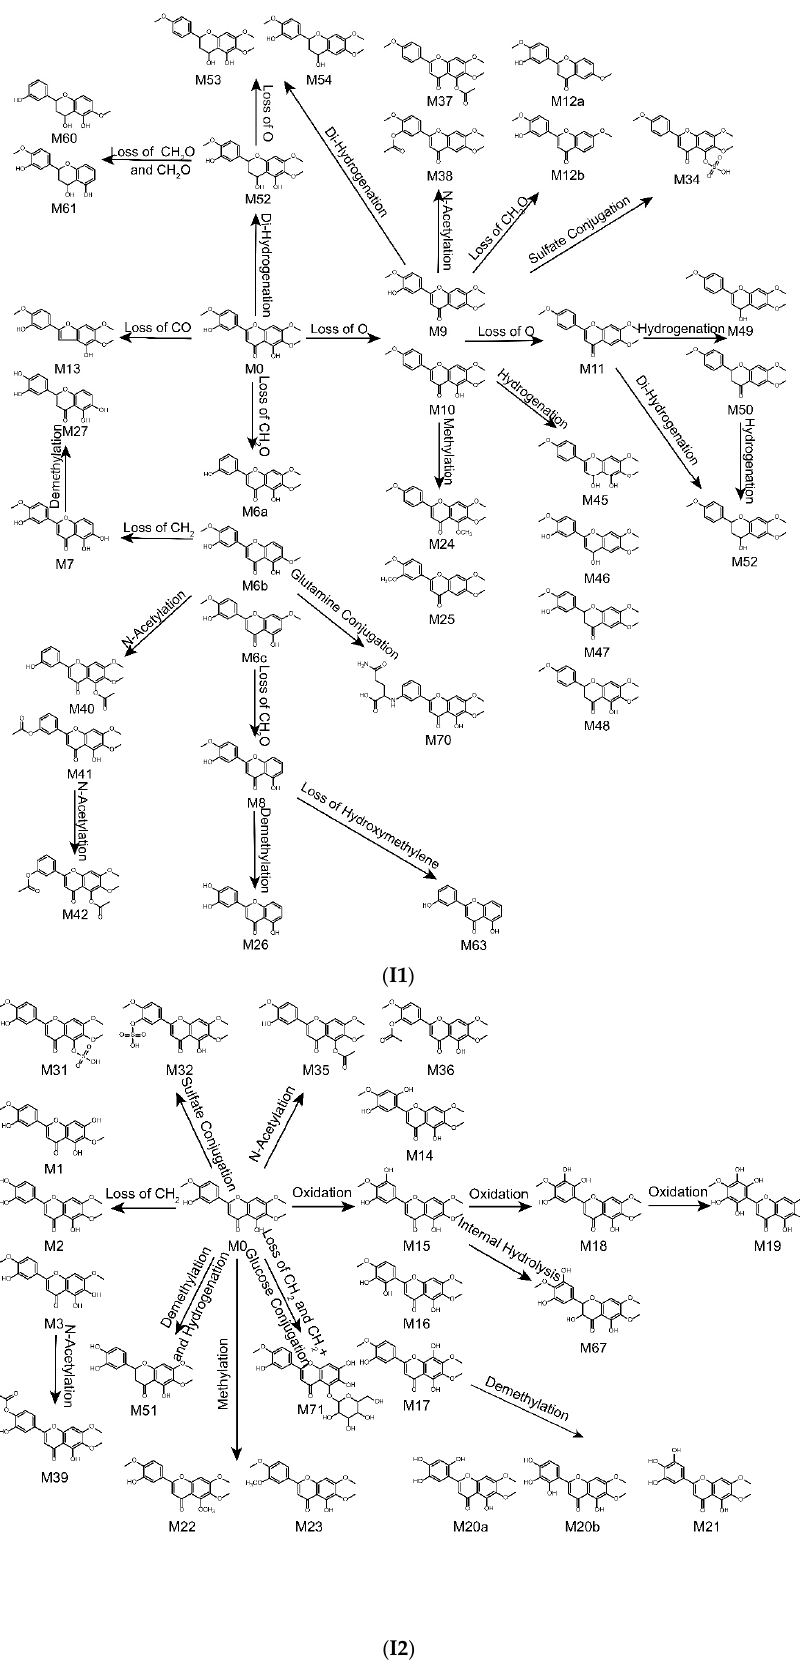
Figure 4. Metabolic profile and proposed metabolic pathways of eupatorin in vivo and in vitro ( G1 , G2 in vivo, H in rat liver microsomes, I1 , I2 in rat intestinal flora).